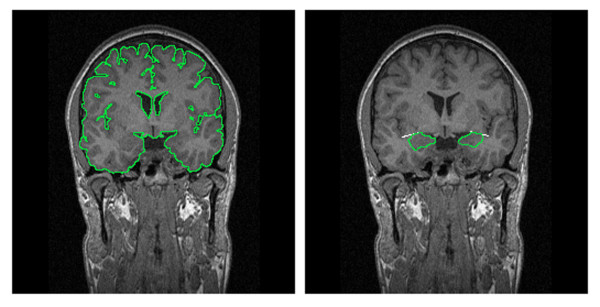
Examples of single 3-D MRI slices, showing delineation of in-slice volumes of total brain (left) and amygdala (right) [green] and the defined superior limit according to Watson et al. [14] [white] within MRreg.